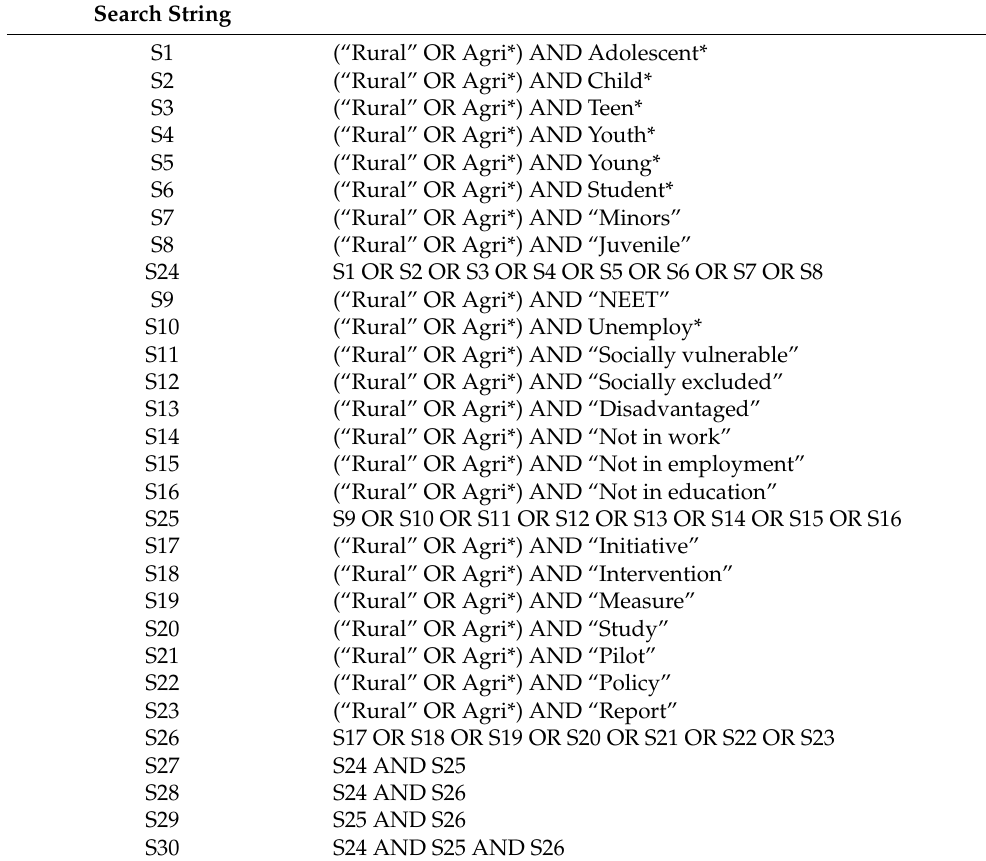
Table 1. Protocol Search Strings Developed by Research